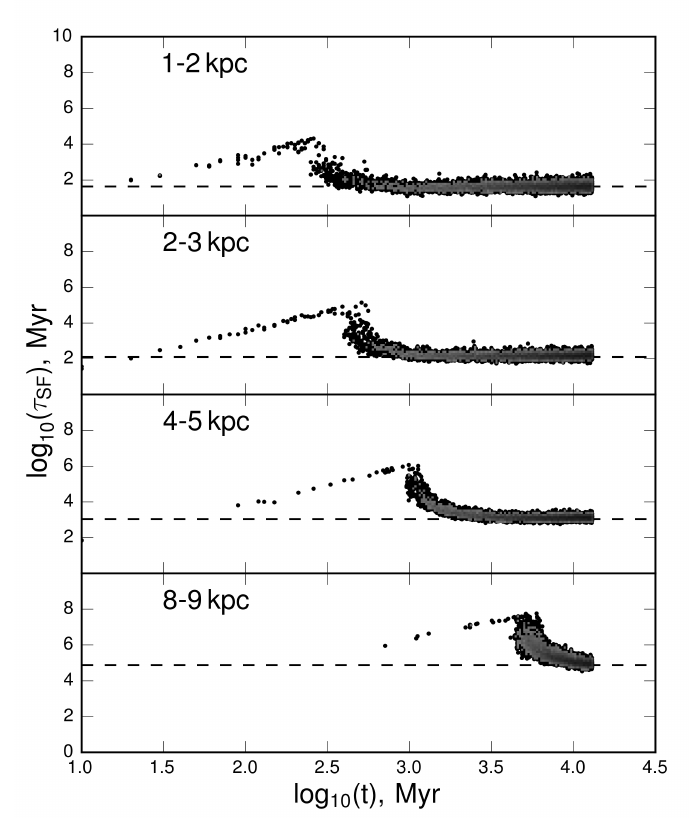
Fig. 2. SF time-scale parameter (cid:28) SF ;i derived from eight 2-D models with a time step of 10 Myr in the 1 kpc wide rings. The dashed line indicates median values of (cid:28) SF ;i derived for the settled SF